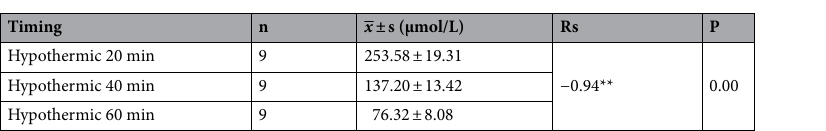
Table 2. Glu values of brain extracellular fluid in different hypothermic perfusion time groups (μmol/L). There was a significant correlation between different hypothermic perfusion times and Glu values. **When the confidence (bilateral) is 0.01, the correlation is significant.